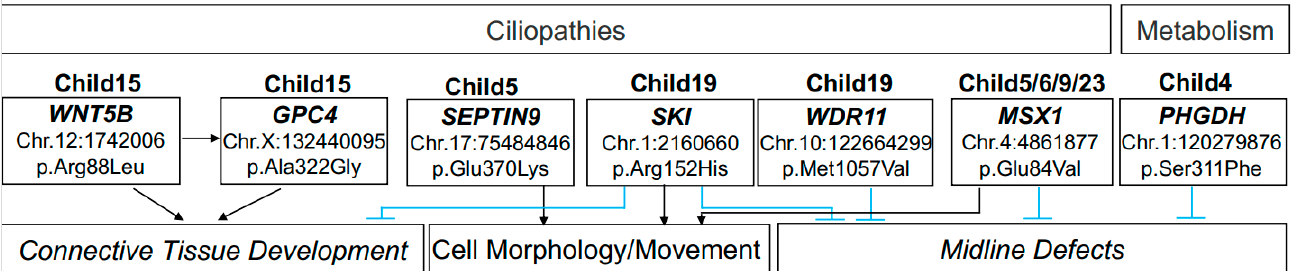
Figure 2. Diagram of variants outlined in our study. The pathways were assessed by KEGG and Ingenuity Pathway Analysis (IPA). The top box indicates a major function of these genes; the middle panel indicates the pedigree and a description of the variant. The bottom panels indicate major disease or function annotation with black errors, indicating the direction of activation and blue lines indicating inhibition within the network.